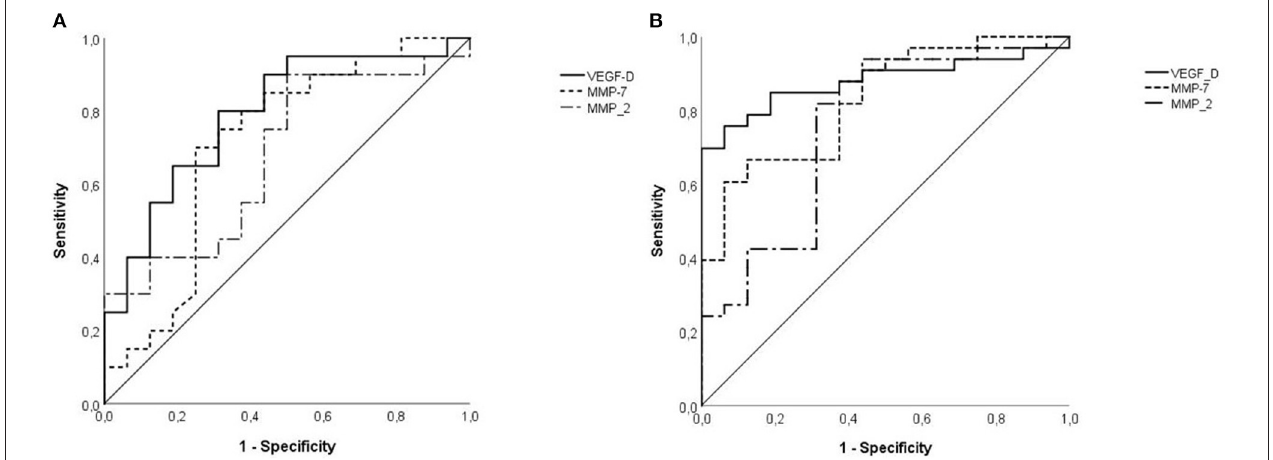
FIGURE 2 | (A) VEGF-D was an effective diagnostic test to predict LAM [area under curve (AUC): 0.879 ± 0.049 (95% CI: 0.782–0.975), p < 0.001] continuous line, respect to MMP2 [AUC: 0.756 ± 0.079 (95% CI: 0.601–0.910)], dotted line, and MMP7 [0.828 ± 0.060 (95% CI: 0.710–0.945), p < 0.001], punctuate line. (B) Specificity of VEGF-D for LAM disease in TSC patients was lower than in previous analysis but remains significant [AUC: 0.791 ± 0.077 (95% CI: 0.640–0.941), p = 0.003], continuous line. MMP-2 has lower accuracy than VEGF-D with an AUC of 0.694 ± 0.088 (95% CI: 0.521–0.867), p = 0.044, dotted line and similarly MMP-7 has an AUC of 0.713 ± 0.090 (95% CI: 0.538–0.889), p = 0.027, punctuate line.